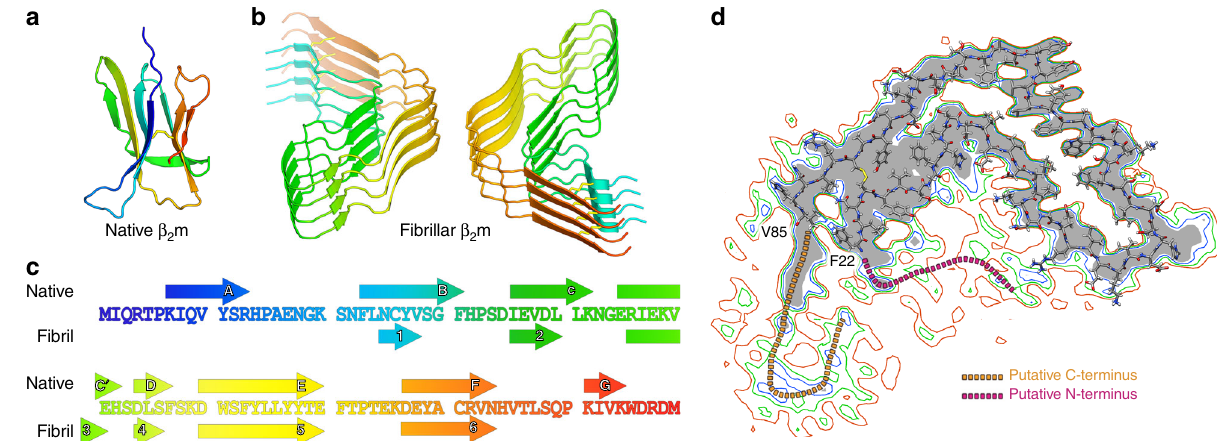
Fig. 4 The structure of β 2 m in its native and fi brillar states. The strands of native β 2 m ( a ) are labelled A – G, and those of the fi brillar β 2 m subunit ( b ) are labelled 1 – 6. Each structure is identically coloured from N-terminus (blue) to C-terminus (red). Residues in the N-terminal (Strand A, blue) and C-terminal (Strand G, red) strands of the native structure are disordered and not present in the core of the fi brillar subunit. c β -strands in the fi brillar subunits coincide remarkably well to β -strands B – F in the native fold, although the B and C strands are shorter. d The N- and C-terminal regions of the β 2 m fi bril are disordered. The atomic model for the ordered portion of the fi bril superimposed over slices through the EM density perpendicular to the fi bril axis at varying contour levels, showing less-ordered regions that must contain the N- and C-terminal residues. The grey density is at a contour level of 0.04, followed by a contour at 0.035 (blue), 0.030 (green), and 0.025 (red), which show the position of weaker, less-ordered